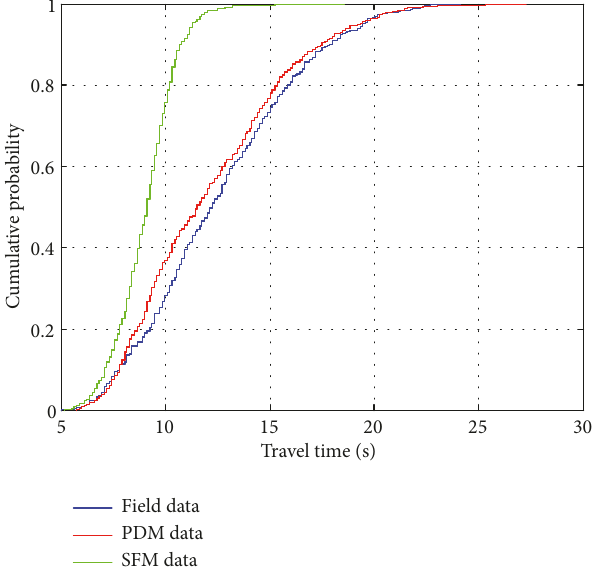
Figure 13: Cumulative probability curve of the travel time at the Xianxia-Jianhe intersection.